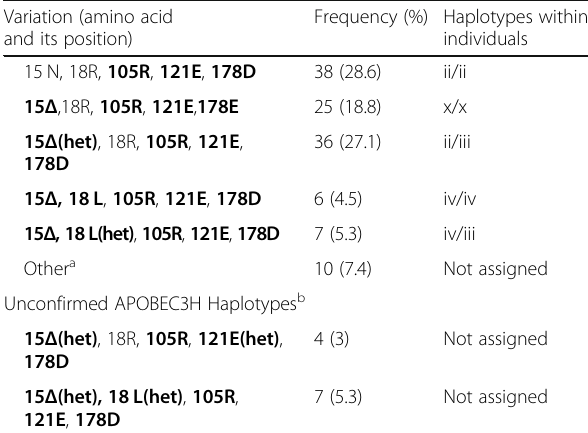
Bold defines variants that are different from those listed in haplotype I in each gene All variants marked by (het) are heterozygous. All others are homozygous Haplotypes are called unconfirmed in our population due to more than 1 heterozygous SNP in the cluster a Refers to the haplotypes with synonymous changes and those of novel SNPs (not reported on the dbSNP) b A3H haplotypes were determined using previous classification people of African descent (Table 5). These included Amer-